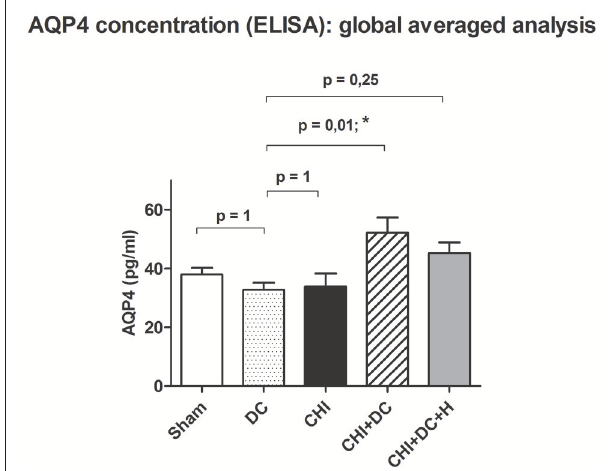
FIGURE 4 | Histogram showing concentration of AQP4 24h after trauma/sham injury according to ELISA assessment. The graph represents analysis of global pooled data i.e., the values obtained separately at the level of ROI (ipsi- and contralateral) as well as outside the ROI (ipsi- and contralateral) have been pooled and averaged. According to the ANOVA analysis, the global AQP4 level was significantly higher in the animals subjected to trauma and craniectomy as compared to craniectomy-only group, serving as reference group (CHI + DC vs. DC, p = 0.01, *). This effect vanished, when additional hypothermia has been applied (CHI + DC + H vs. DC, ns, p > 0.05). CHI, closed head injury; DC, decompressive craniectomy; H, hypothermia; ROI, region of